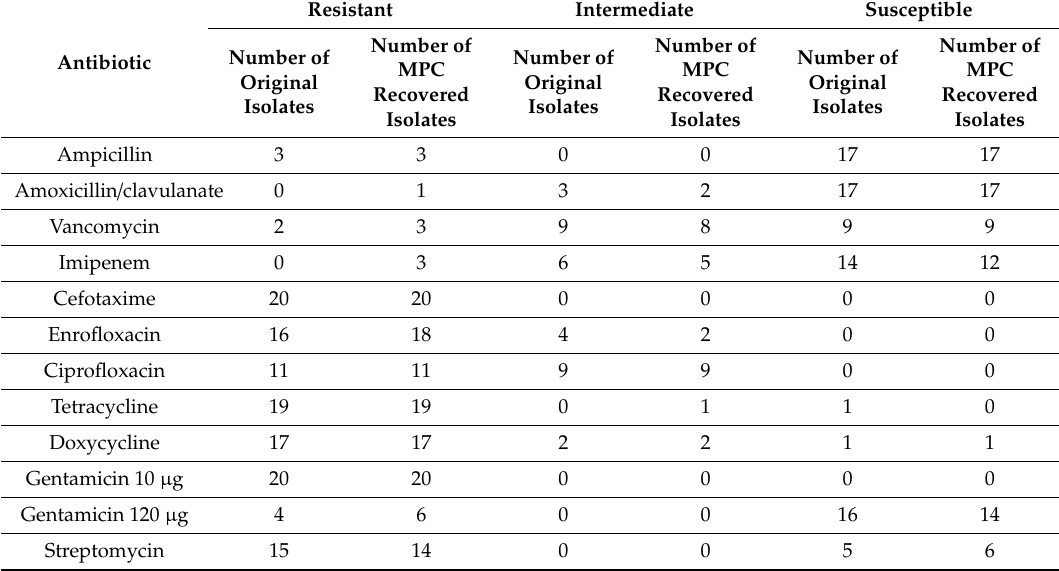
Table 2. Representation of the resistance levels of the enterococci from the original collection, obtained from the oral cavity of dogs with PD, and the isolates recovered in the MPC protocol, determined by disc di ff usion method according to Clinical and Laboratory Standards Institute (CLSI) guidelines.